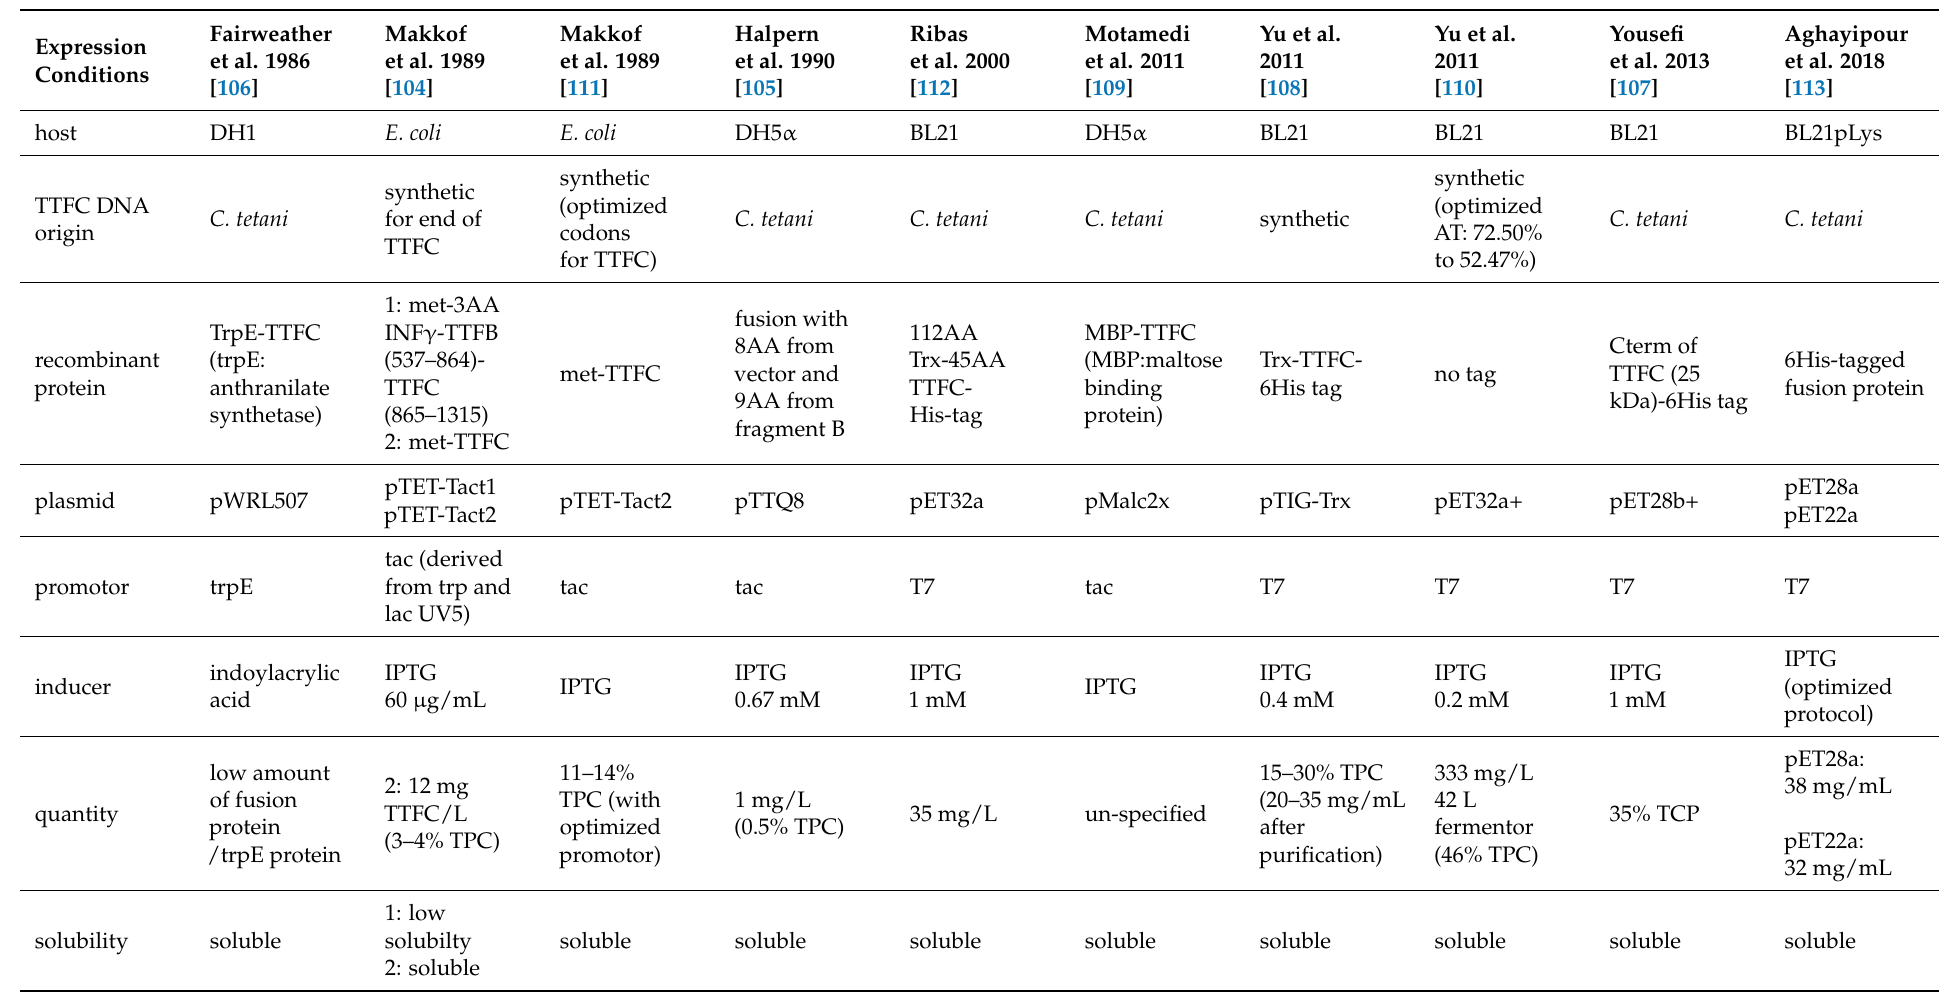
Table 4. Expression of recombinant TTFC in E. coli